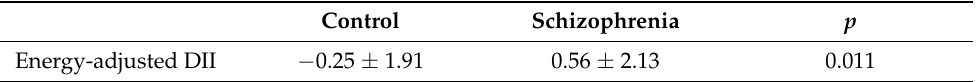
Table 5. Energy-adjusted dietary inflammatory index (DII) scores of control and schizophrenia subjects. Control